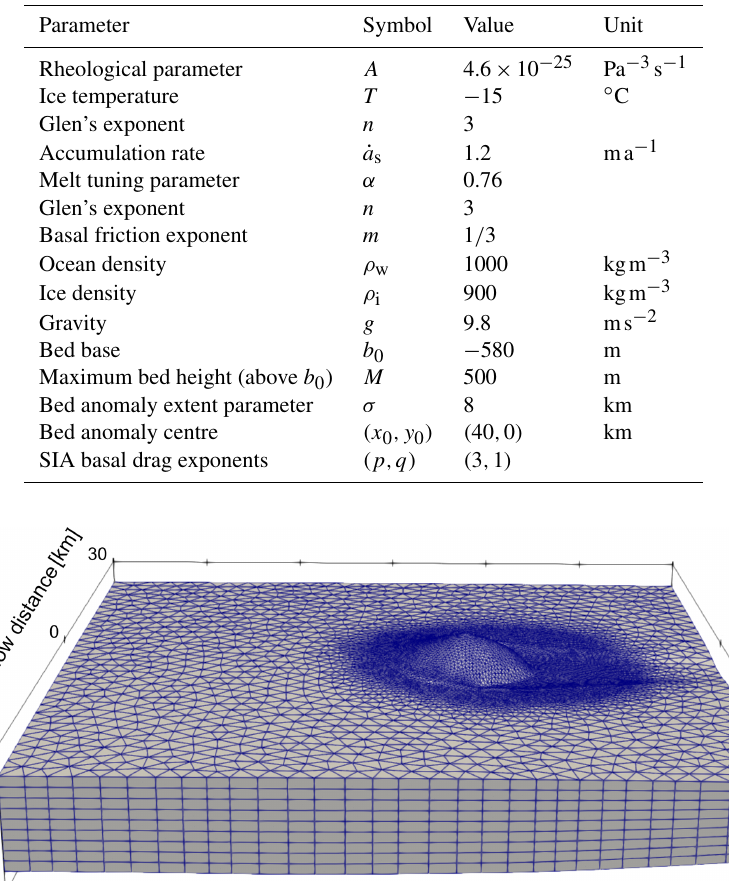
Table 1. List of parameters used in the simulations.